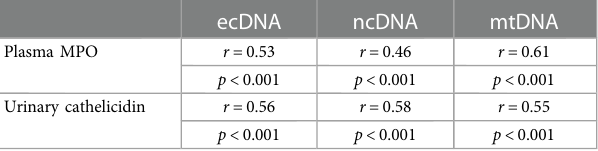
TABLE 2 Correlation between antimicrobial peptides and ecDNA in urine of children with UTI. ecDNA ncDNA